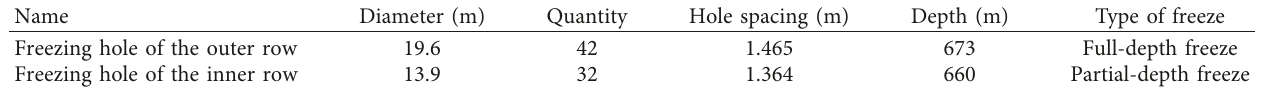
Table 1: Freezing hole layout parameters.